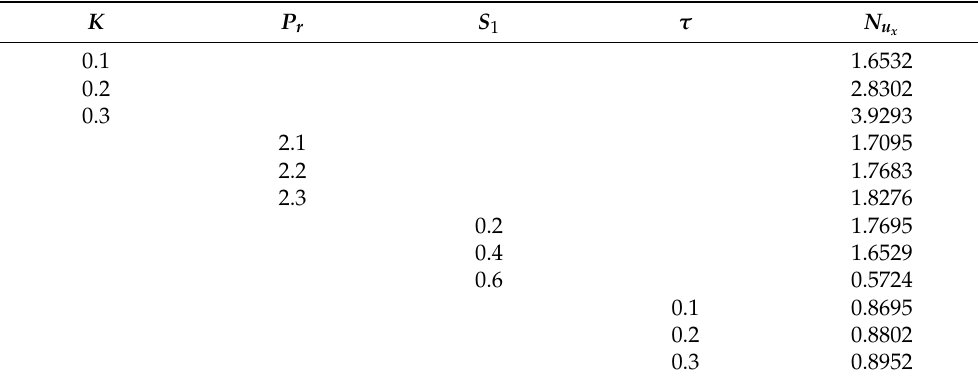
Table 2. Numerical variations of Nusselt number against some dominating parameters at R d = 0.3, θ w = 0.2 and K =